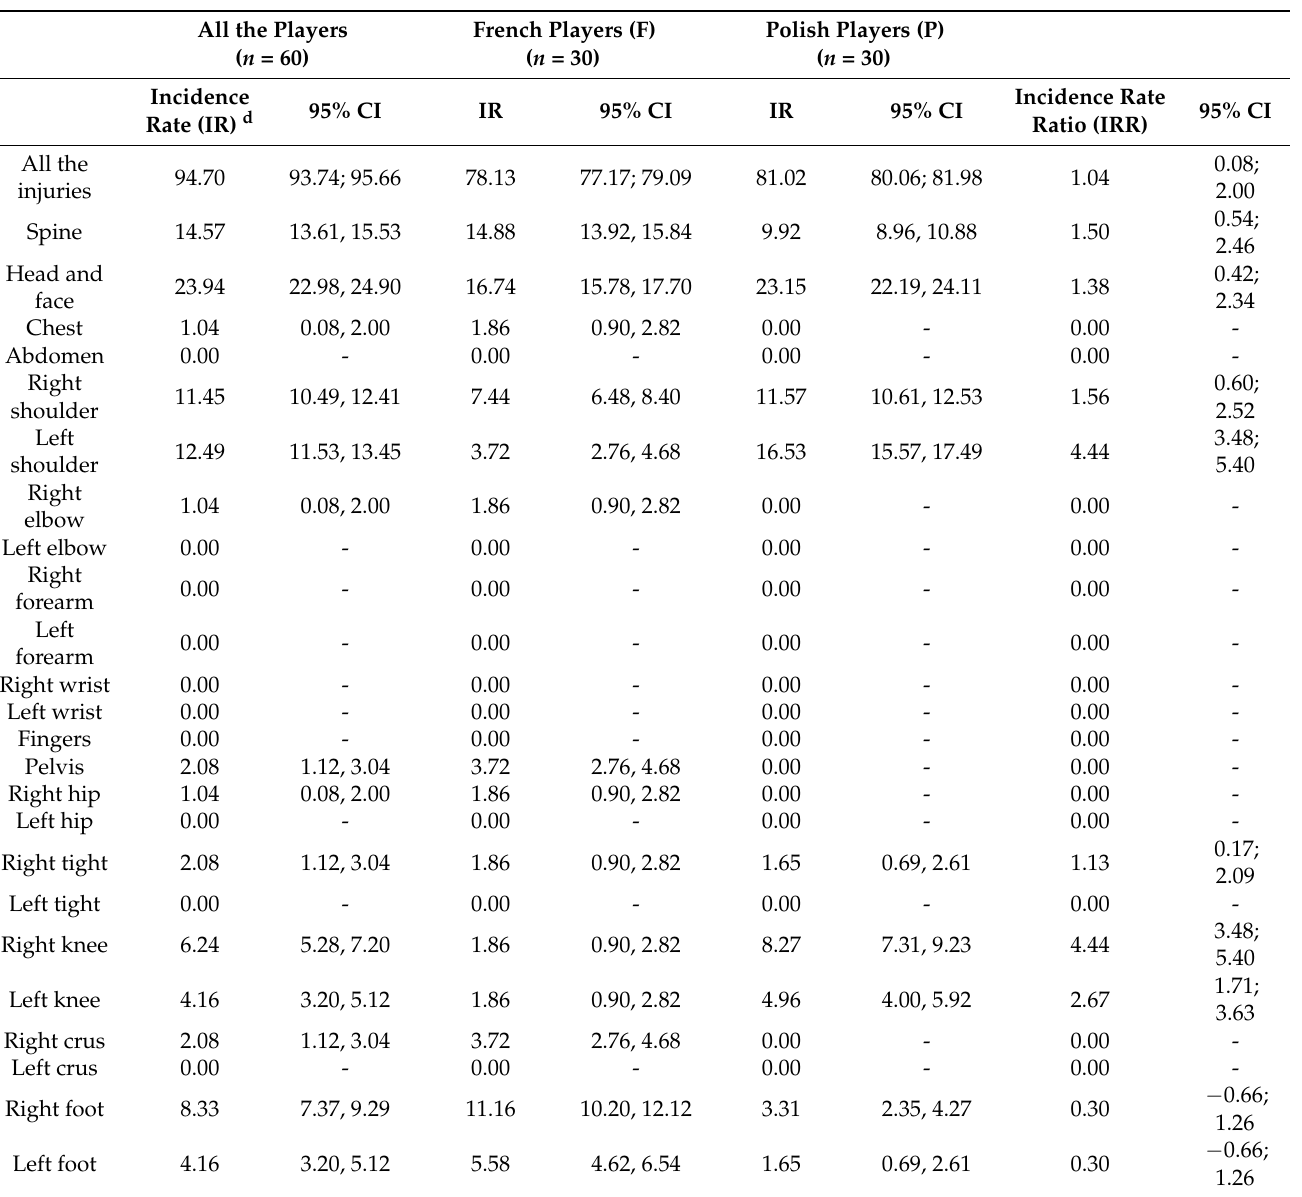
Table 5. Incidence rates of injuries obtained among the rugby players ( n = 60) by